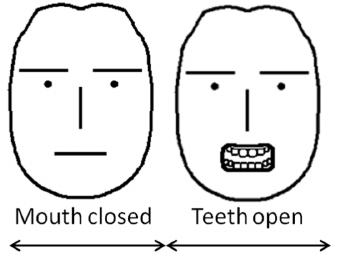
Figure 8. Computational model of polarity in Hypothetical conditionals.